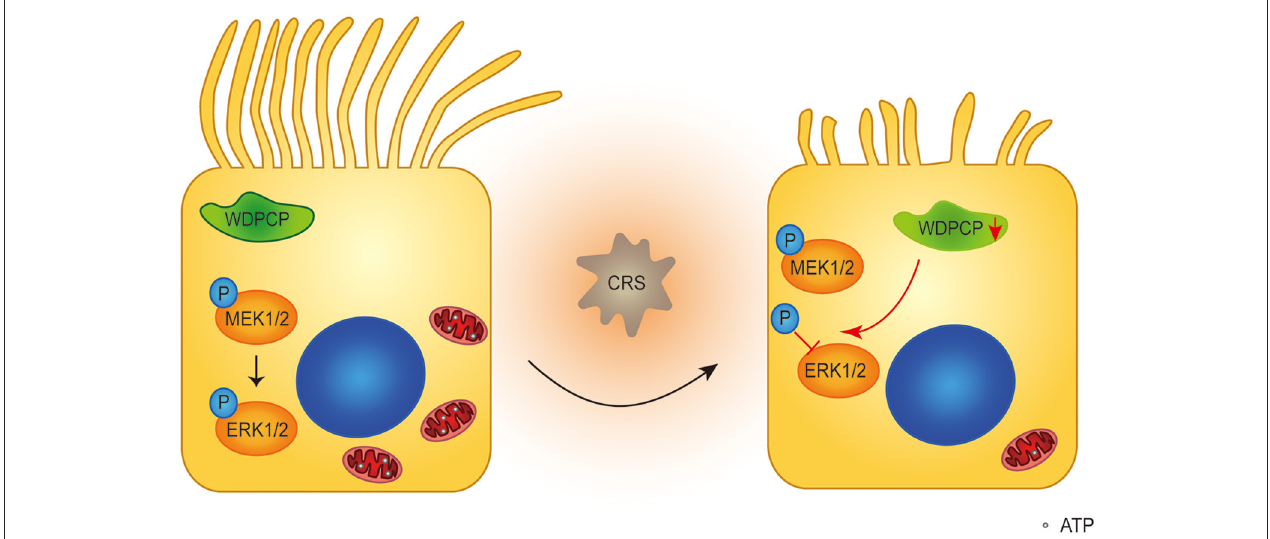
FIGURE 6 | Schematic diagram of WDPCP regulating ciliogenesis and cilia function in nasal epithelium. Our results showed that WDPCP could work through MAPK/ERK pathway to regulate mitochondrial biogenesis and function. In the case of CRSwNP, HSECs low expressed WDPCP, and phosphorylation of ERK1/2 was partially blocked, further affecting the number and function of mitochondria. This mechanism might lead to the poor ciliation and cilia dysfunction of nasal epithelium in